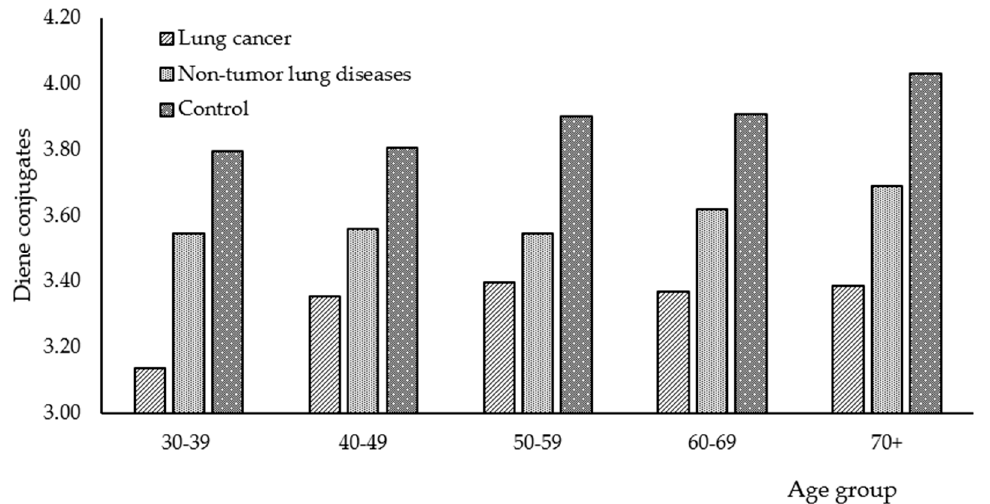
Figure 2. Levels of diene conjugates in saliva of patients with lung cancer, non-malignant lung diseases and of apparently healthy patients.